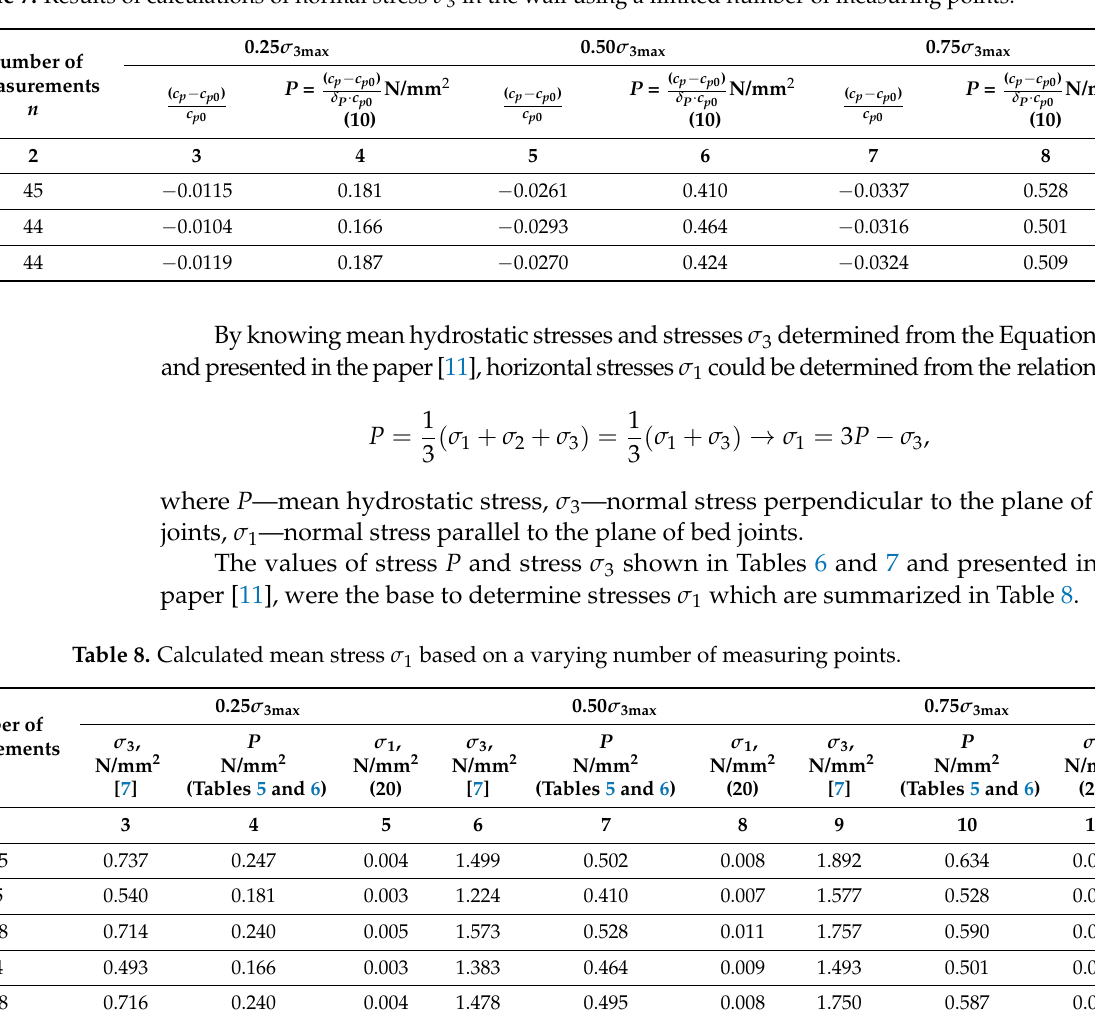
Table 7. Results of calculations of normal stress σ 3 in the wall using a limited number of measuring points.